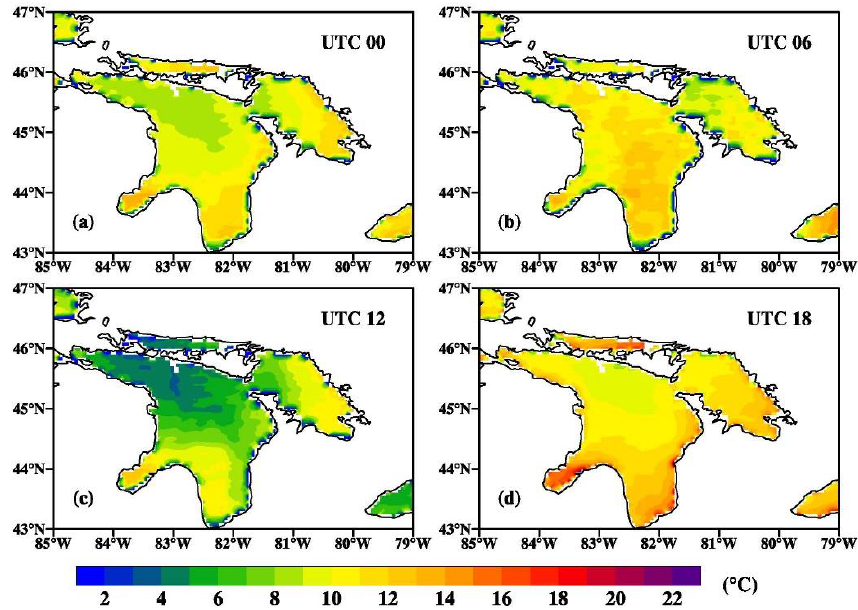
Figure 4. Average LST at different UTC times from GOES-E during the period of 2004–2009. Shown are the following cases: ( a ) UTC00; ( b ) UTC06; ( c ) UTC12; and ( d ) UTC18.